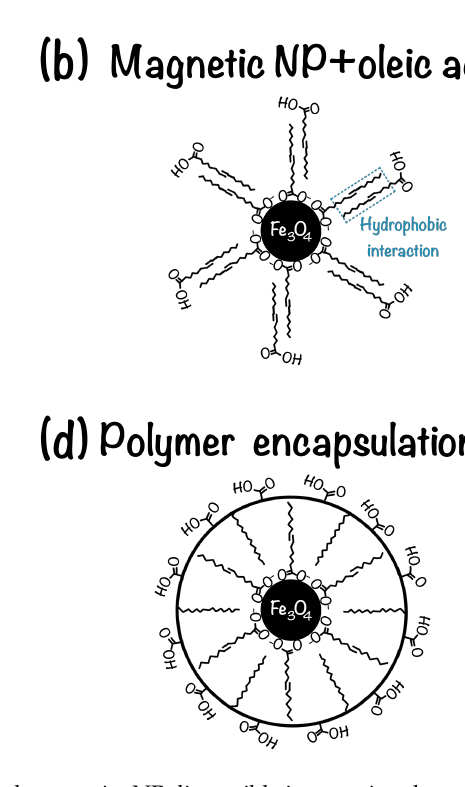
Figure 2. Schematic drawing of an oleic acid coated magnetite NP dispersible in organic solvents ( a ). Water solubility is achieved by addition of surplus oleic acid resulting in a double layer-oleic acid coated NPs ( b ), and by using an amphiphilic polymer ( c ) that encapsulates the NP and native surface ligands ( d ), thereby providing functional molecules capable of secondary conjugation. Figure adapted from reference